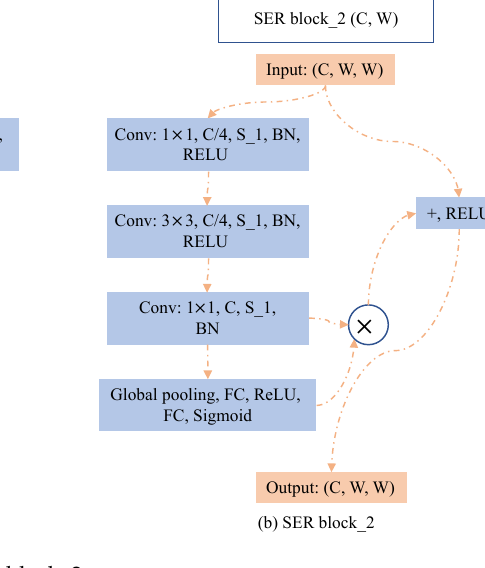
Figure 7. The structure of SER block_1 and SER